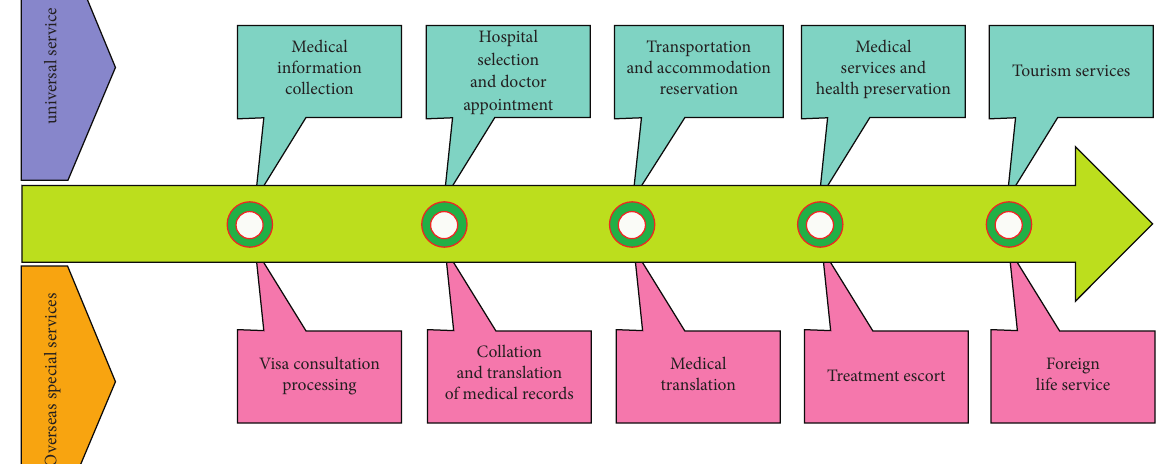
Figure 1: Medical and tourism industry